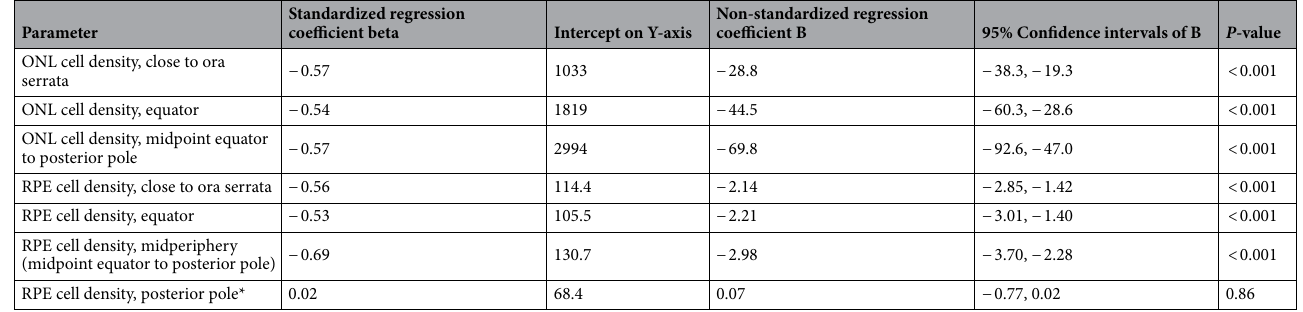
Table 2. Associations of the retinal outer nuclear layer (ONL) cell count (per mm) and retinal pigment epithelium (RPE) cell count (per mm), measured in various ocular regions, with axial length. *With eyes with congenital glaucoma excluded.